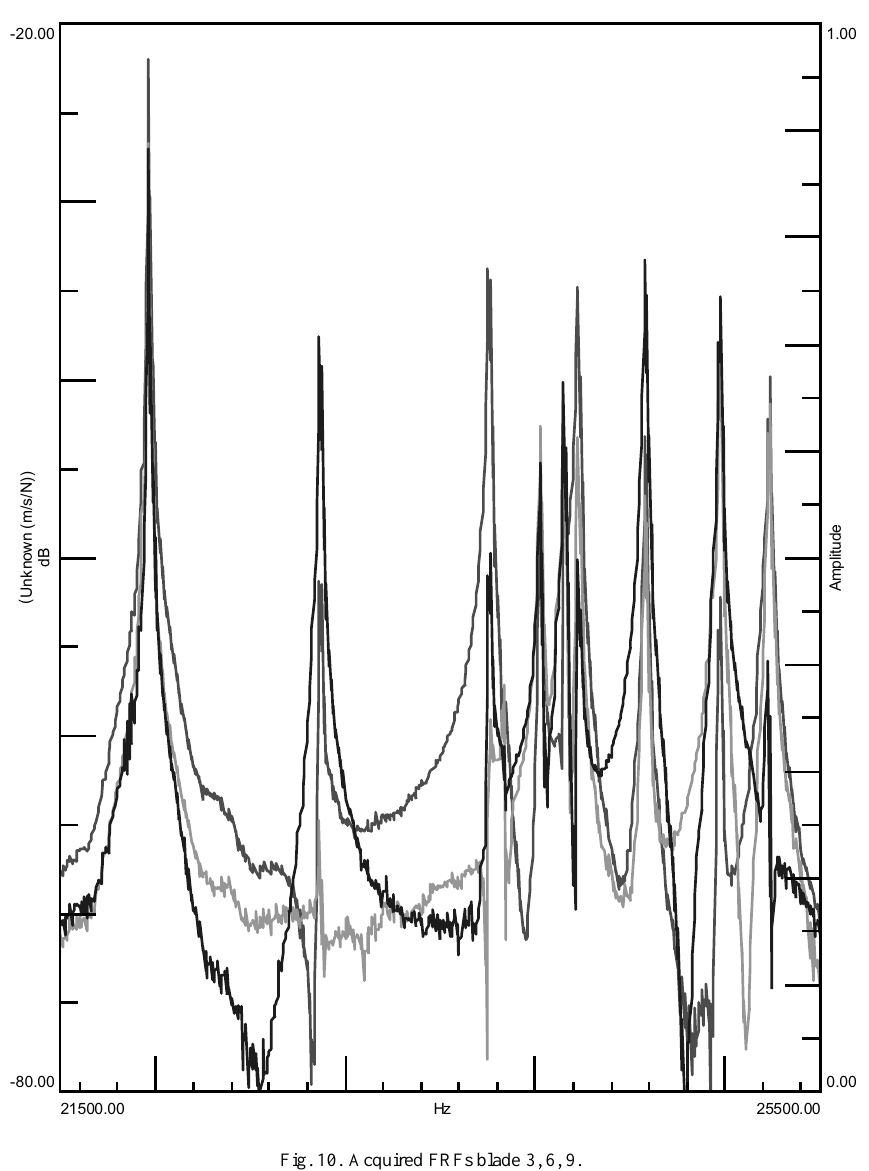
Fig. 10. Acquired FRFs blade 3, 6,